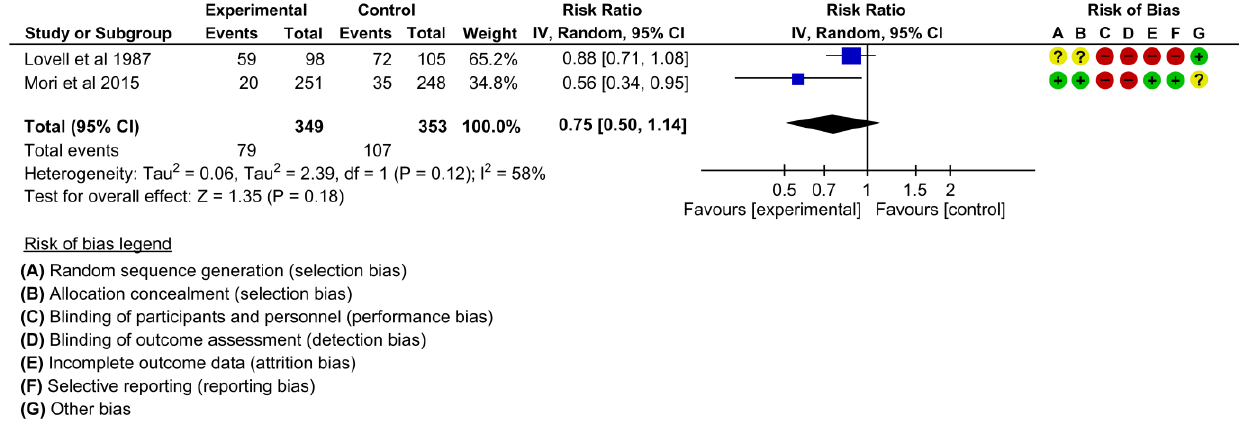
Figure 10. Meta-analysis for the effect of MCH handbook interventions vs. standard care on drinking during pregnancy [19,22]. Red color with a − symbol means a high risk of bias, yellow color with a ? symbol means an unclear risk of bias, and green color with a + symbol means a low risk of bias.